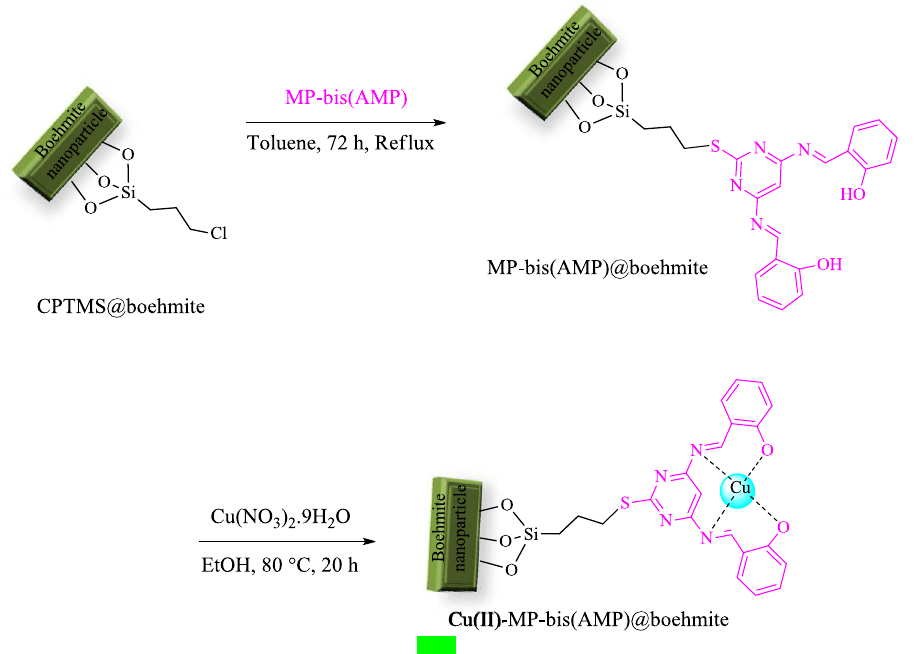
Figure 1. Synthesis of